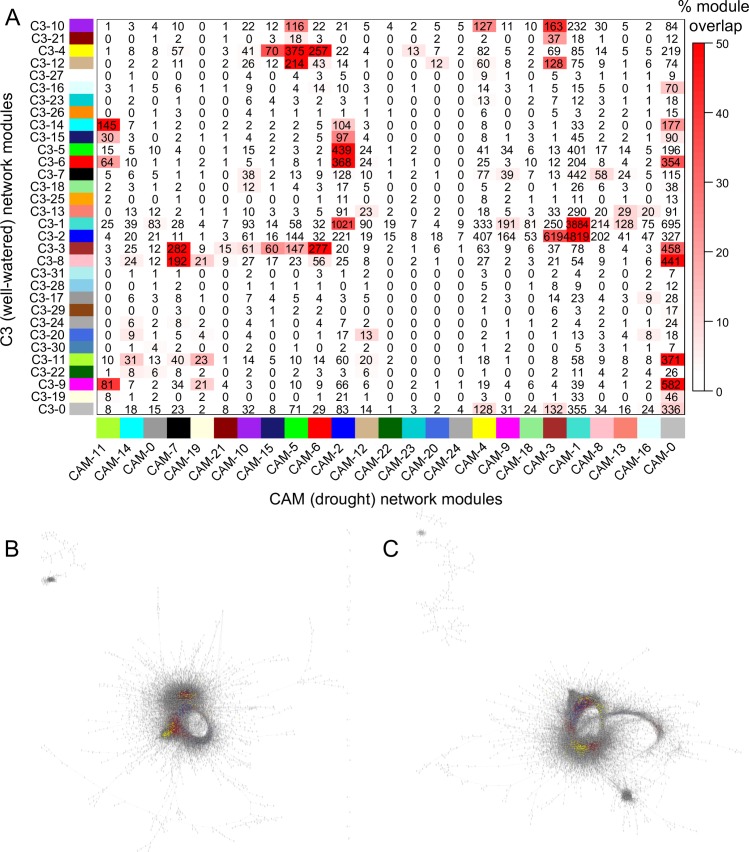
Gene co-expression and interaction networks between the well-watered (C3) and drought (CAM-cycling) S. album.(A) A consensus matrix including the 32 modules for the C3 network and 25 modules for the CAM-cycling network is shown. The number of genes shared between any two modules is shown in the matrix and numbers highlighted in red have significant overlap (Fisher’s exact test), with the percentage of shared genes depicted by a red gradient. Gene interaction networks of C3 (B) and CAM-cycling (C) timecourses are plotted and core CAM pathway genes and their interacting partners are highlighted in yellow.